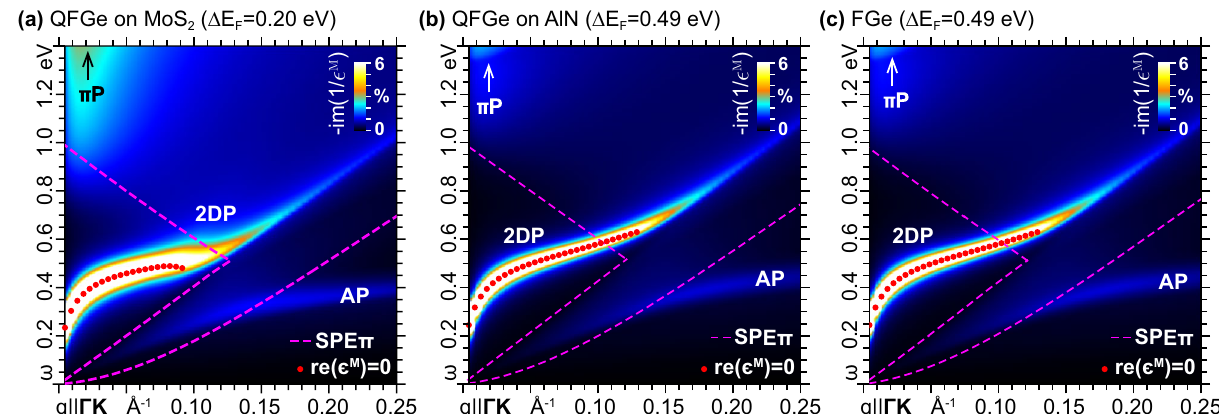
Figure 8. Loss function (in arb. units) of ( a ) QFGe on MoS 2 , ( b ) QFGe on AlN , and ( c ) FGe for applied momentum transfers along Ŵ K . The Fermi level is driven well above the top of the σ -like bands, at 0.49eV with respect to the Dirac cone vertex, in such a way that only the massless 2DP and AP modes are present. The color scale is normalized to the highest FIR-MIR peak, with the undamped plasmon resonances and the SPE π region delimiters marked as in in Figs.